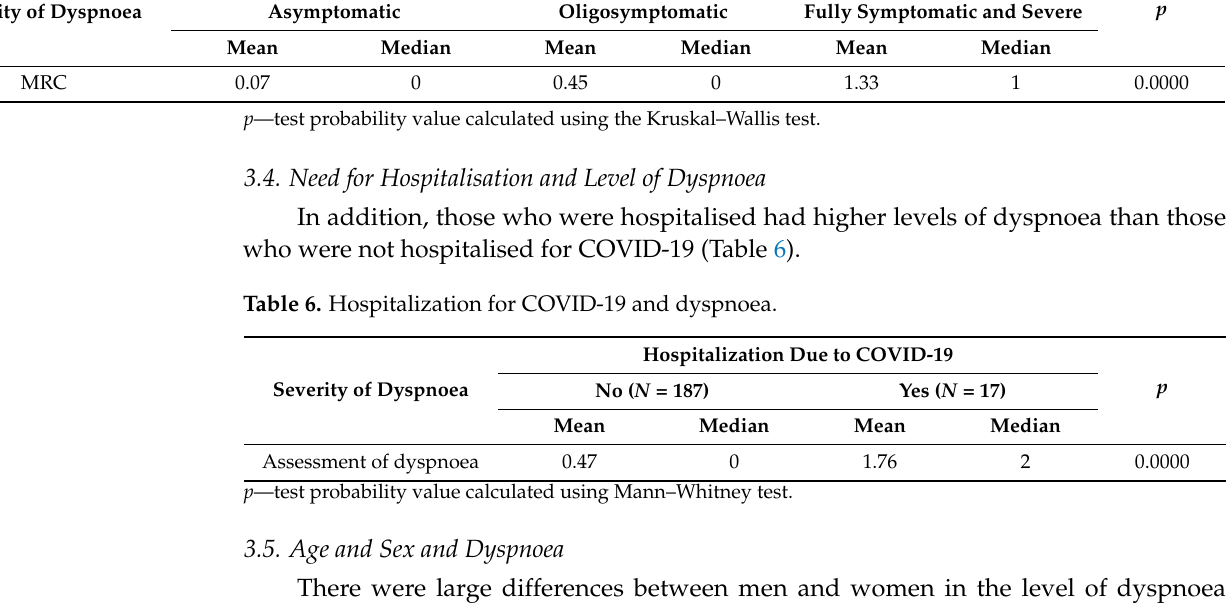
Table 5. Severity of infection versus level of dyspnoea.